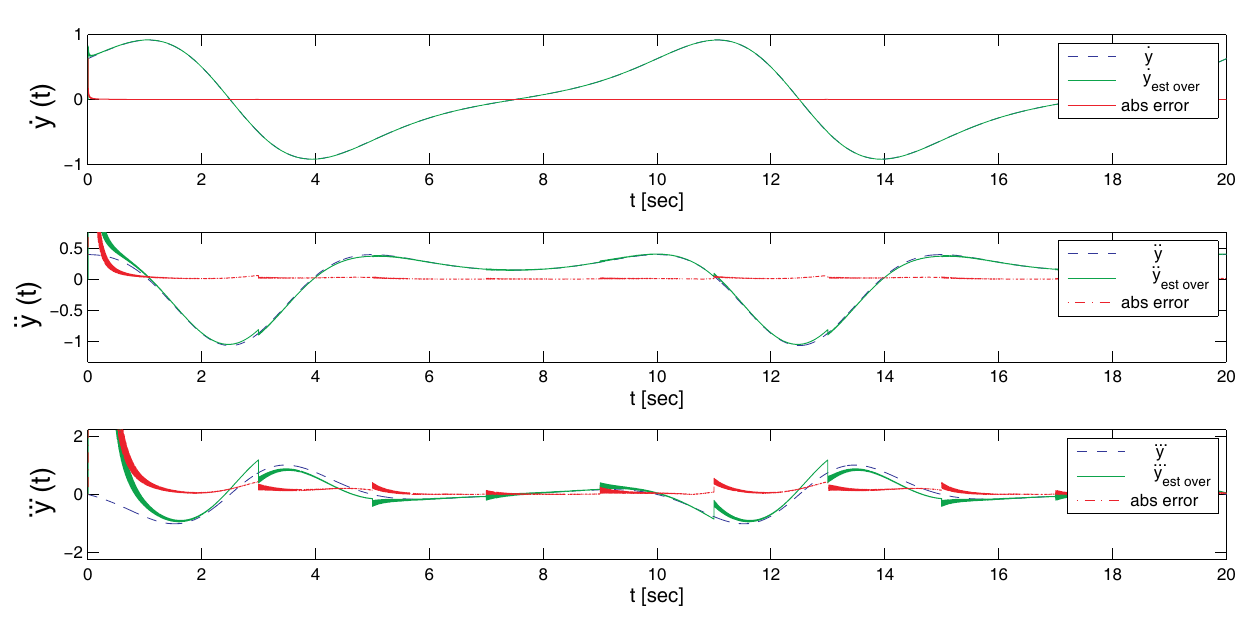
Figure 4. Overlapped estimator for the first, second and third derivatives.